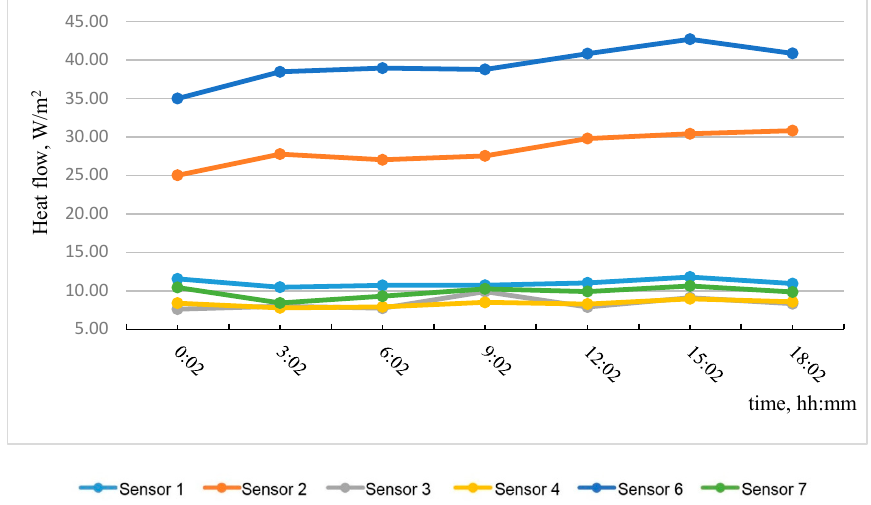
Figure 10. Temperature on the specimen No. 2 surface with time.